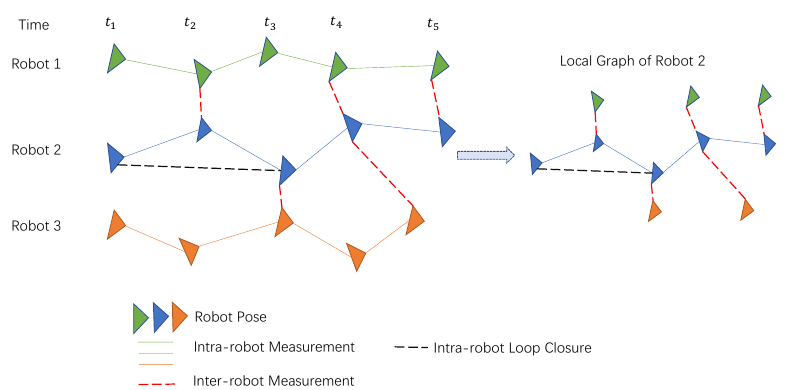
Figure 3. Distributed graph optimization for multi-robot localization. The left is the global pose graph, and the right figure is the local pose graph of Robot